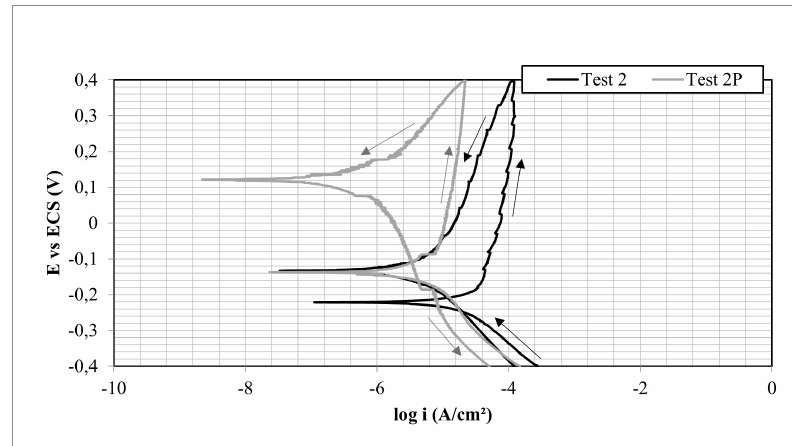
Figure 13. Cyclic voltammetric curves for tests 2 and